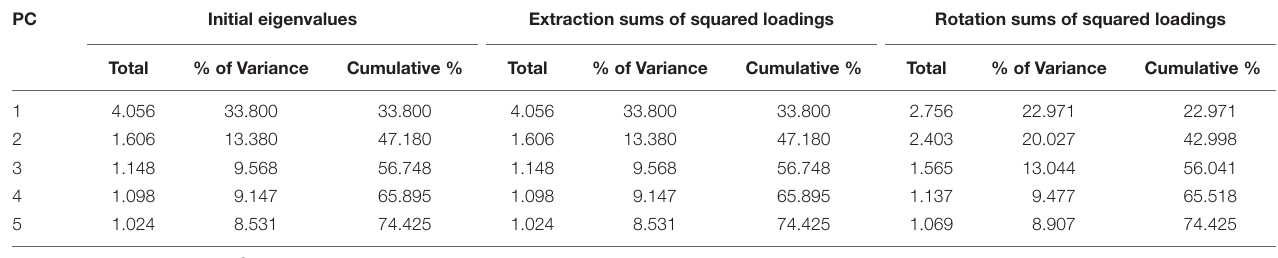
TABLE 3 | Factor loading matrix: the loadings higher than | 0.6| are bolded and indicated as the significant loadings for the corresponding